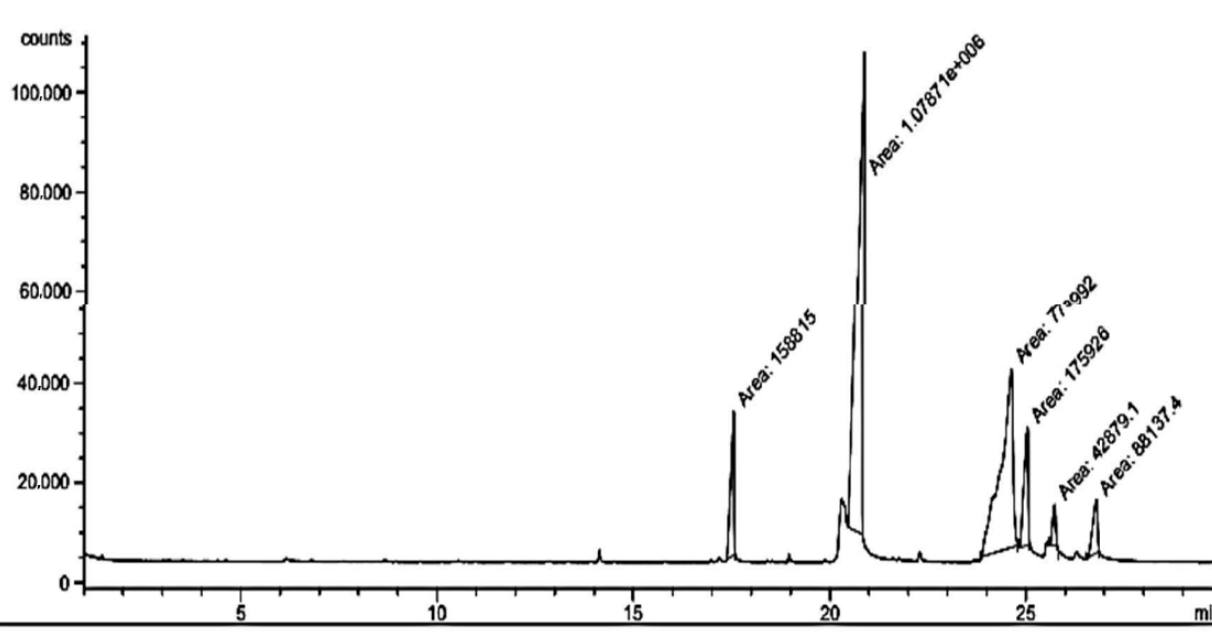
Figure 5. Gas chromatography-mass spectrum of the biosurfactant of Candida sphaerica cultivated in medium supplemented with 9% vegetable oil refinery residue and 9% corn steep liquor.